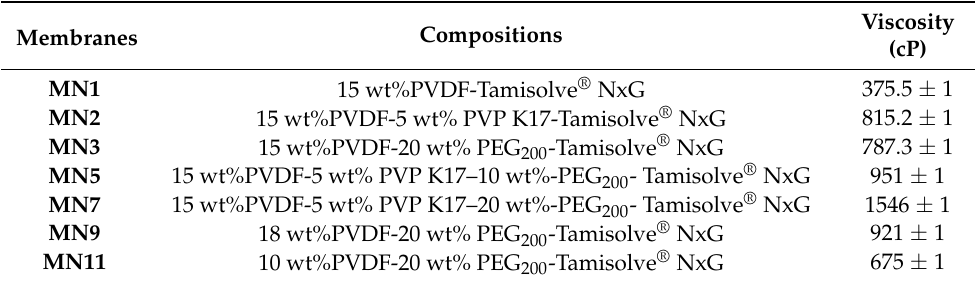
Table 3. Dynamic viscosity of solutions